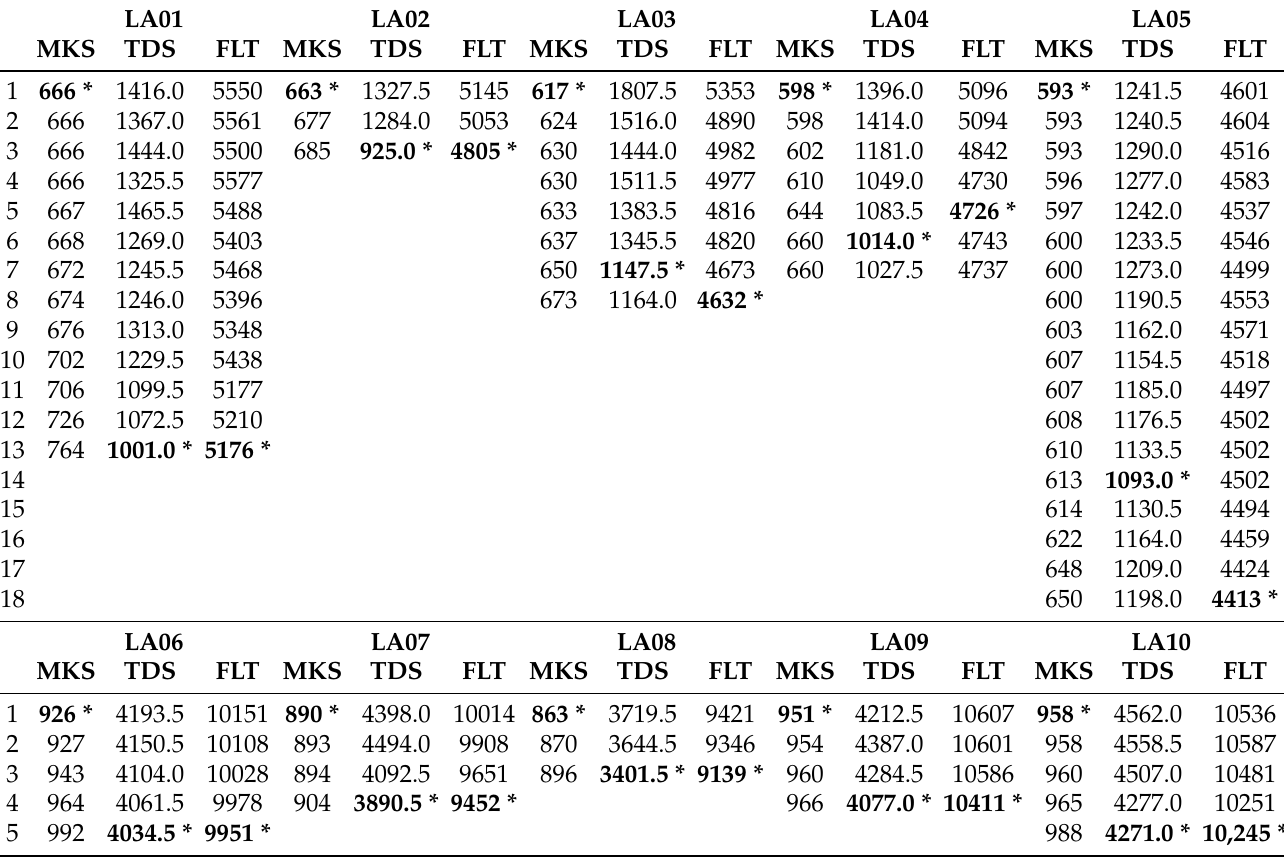
Table A9. Non-dominated front obtained by CMOTA for the JSSP instances proposed by